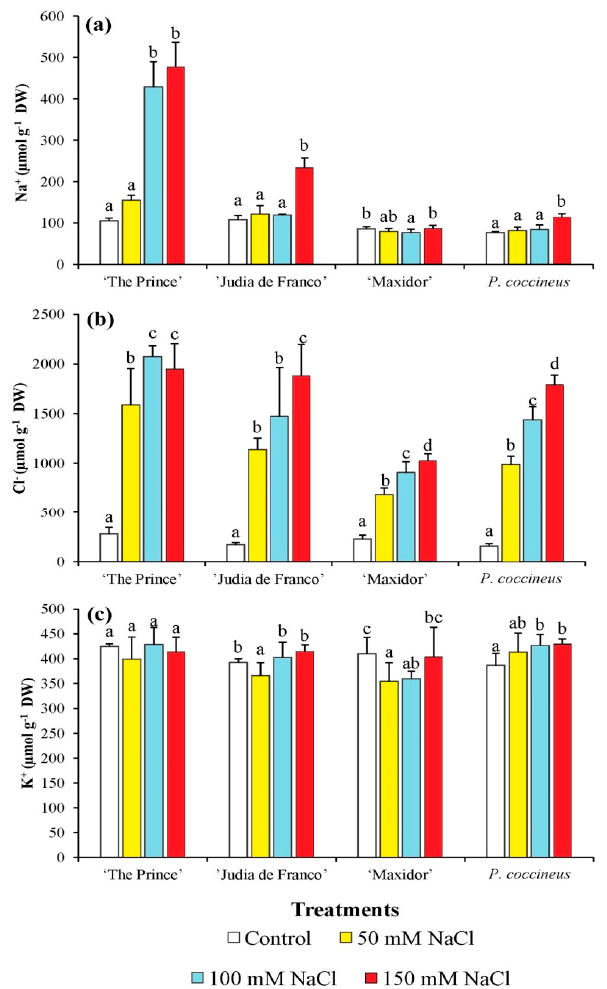
Figure 2. Salt stress-induced changes in ions levels (Na + , Cl − , and K + ) of 5-week-old Phaseolus plants. Salt stress-induced changes in: ( a ) sodium, ( b ) chloride, and ( c ) potassium contents in leaves of Phaseolus plants of the studied cultivars. Measurements were performed after three weeks of treatment. The values shown are means with SD ( n = 5). For each cultivar, different lowercase letters indicate significant differences between treatments according to the Tukey test ( α = 0.05).